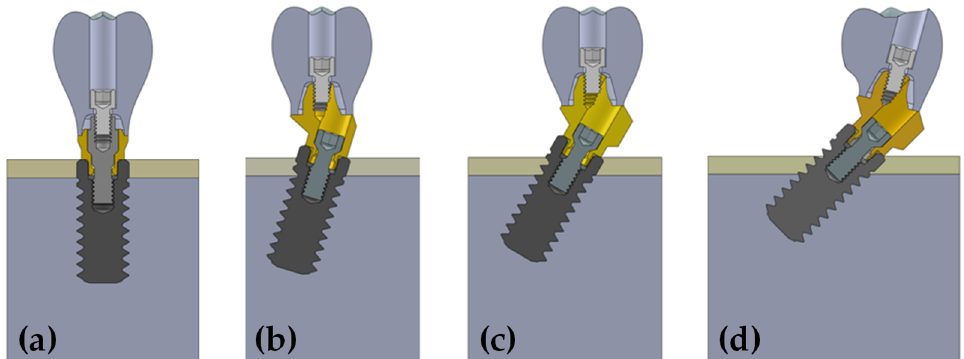
Figure 1. 3D model of single-unit implant with straight transepithelial abutment of 2 mm was used ( a ). 17 ◦ —tilted abutment with 17 ◦ —angle transepithelial abutment of 2 mm in height ( b ). 30 ◦ —tilted abutment with 30 ◦ —angle transepithelial abutment of 2 mm in height ( c ). 45 ◦ -tilted abutment with 30 ◦ —angle transepithelial abutment of 2 mm in height ( d